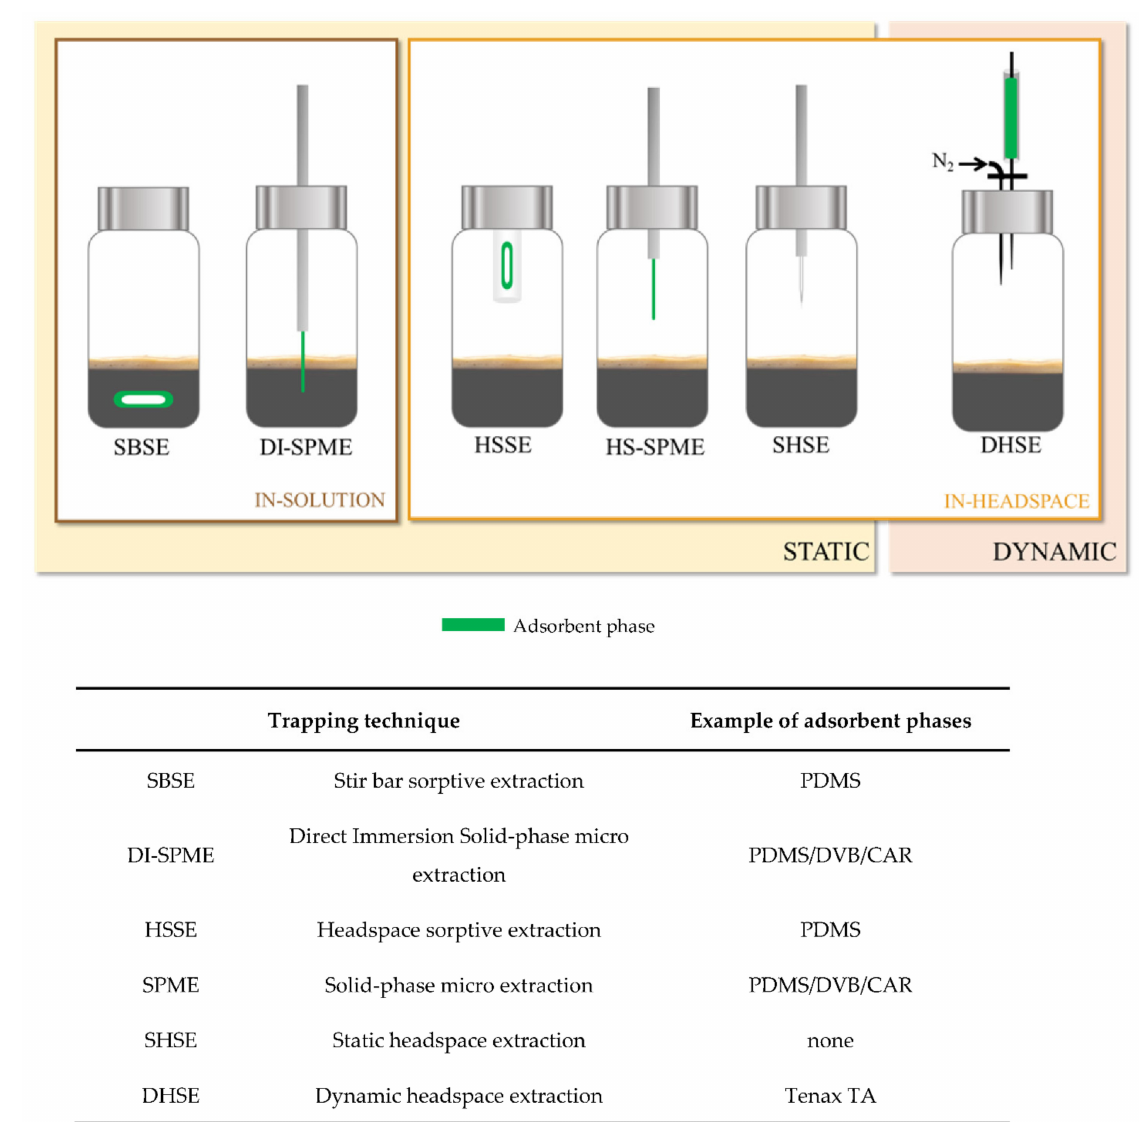
Figure 2. Schematic representation of the six volatile trapping techniques used for VOCs extraction in EC. The adsorbent coatings are highlighted in green. Abbreviations are explained in the table